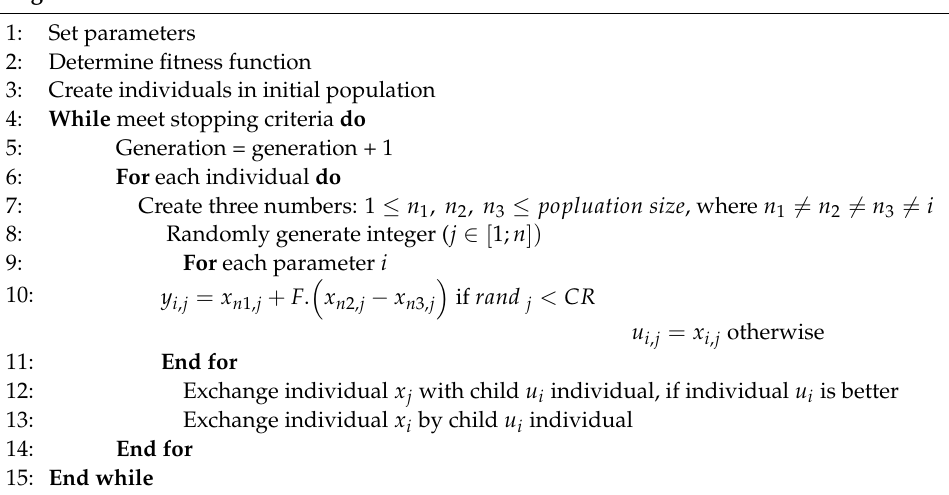
Algorithm 2. Differential